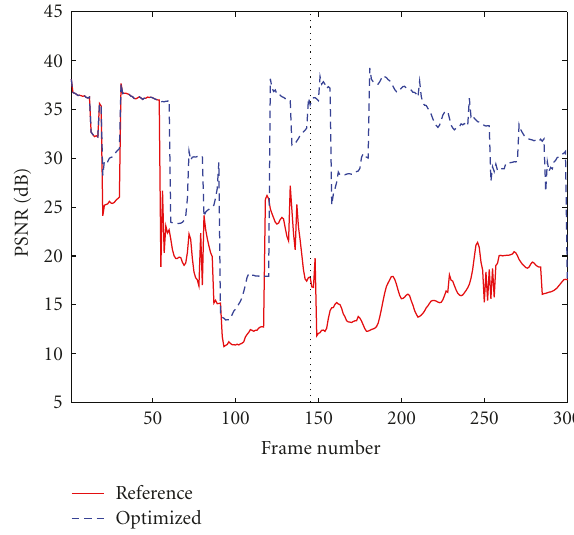
Figure 11: PSNR comparison versus frame number between reference and optimized processings.